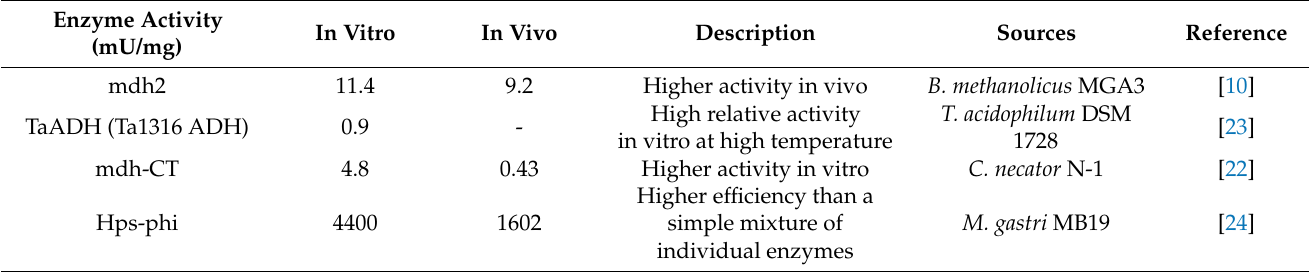
Table 3. Measured activities of different enzymes from different sources. In vitro activities were measured using purified proteins; in vivo activities were measured using E. coli cell suspensions har- boring the corresponding enzymes. Description contains the advantages of each enzyme mentioned in the literature. The hyphen (-) indicates activity not detected. Sources column specifies the species source of these enzymes. Shown are the mean values of three biological